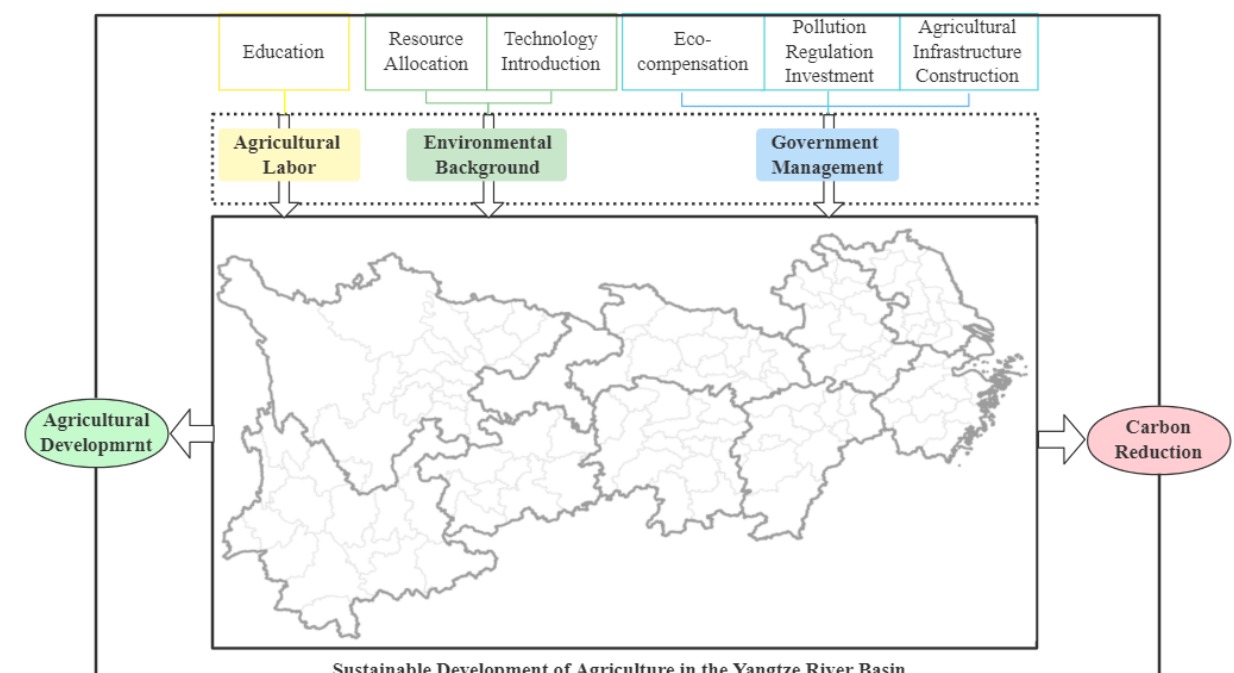
Figure 10. Paths to improve eco-efficiency of agricultural land.